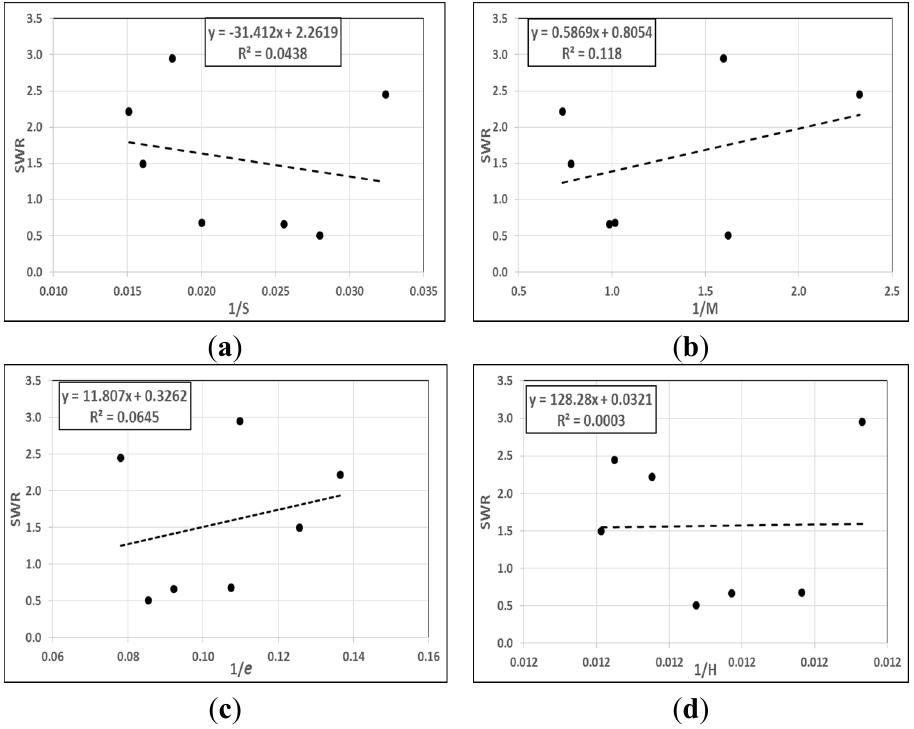
Figure 4. Correlation between the individual mechanical properties and specific wear rate (SWR) of the materials. ( a ) Tensile strength; ( b ) Modulus of elasticity; ( c ) Elongation at the break; ( d ) Hardness.